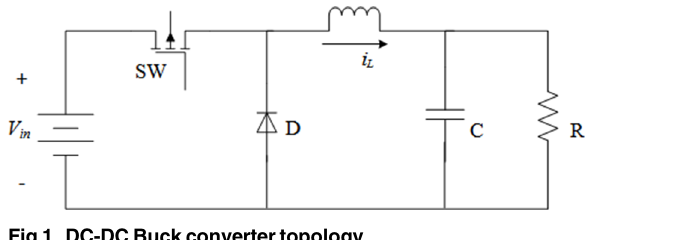
Fig 1. DC-DC Buck